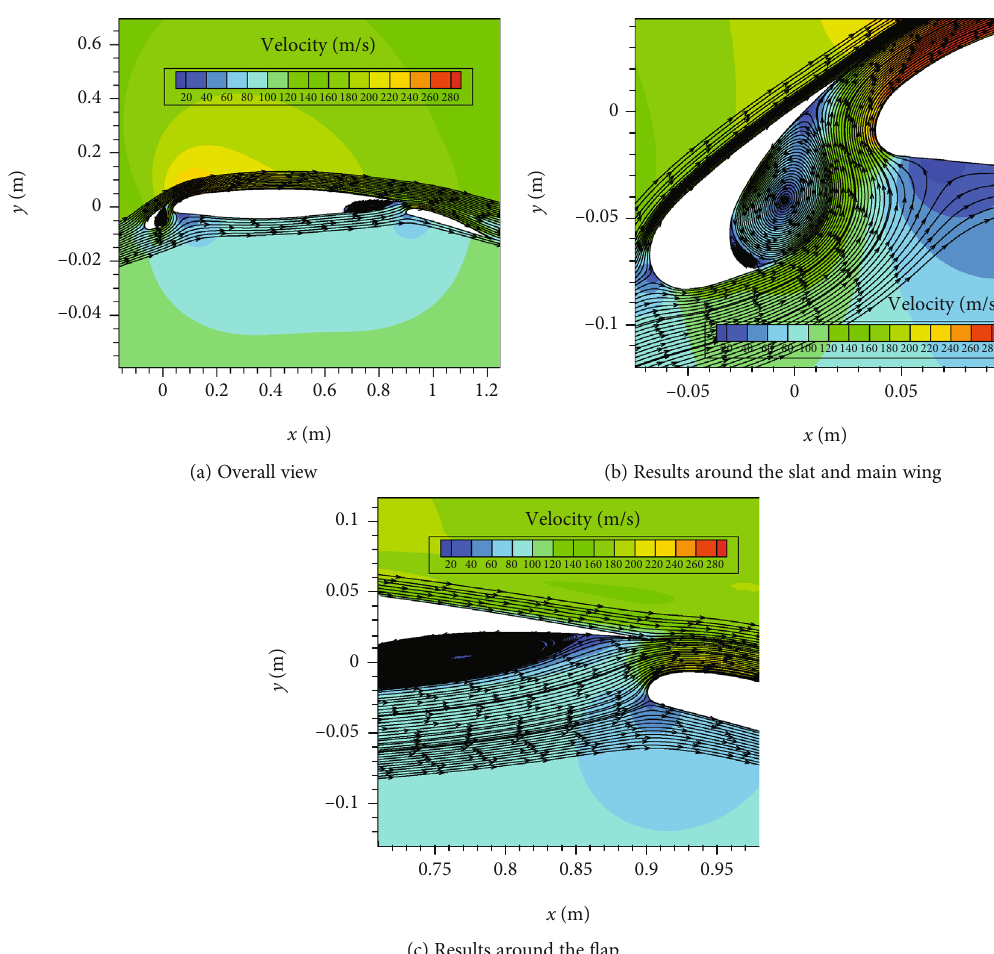
Figure 8: Contour of air velocity and the streamlines around the multielement Figure 5. Similar to what happened to the cylinder, the drop- let trajectories do not deviate from the air fl ow direction until they reach the vicinity of the airfoil ’ s leading edge. Part of the droplets impacts on the airfoil. Due to the negative angle of attack, water droplets are more likely to hit the suction side of the airfoil surface. When passing by the airfoil, the droplets closer to the surface deviate from the streamline more obvi- ously in contrary to the further ones. Near the airfoil surface, a concentrated zone of the path lines is also observed with the overlaps and crossings of the droplet trajectories, also alike to the situation in the cylinder case. These phenomena can also be found in references [5, 26]. Since the trajectory overlap- ping and crossing regions are located out of the impingement limits, they are considered to have no e ff ects on the droplet collection e ffi ciency and have not attracted much attention.